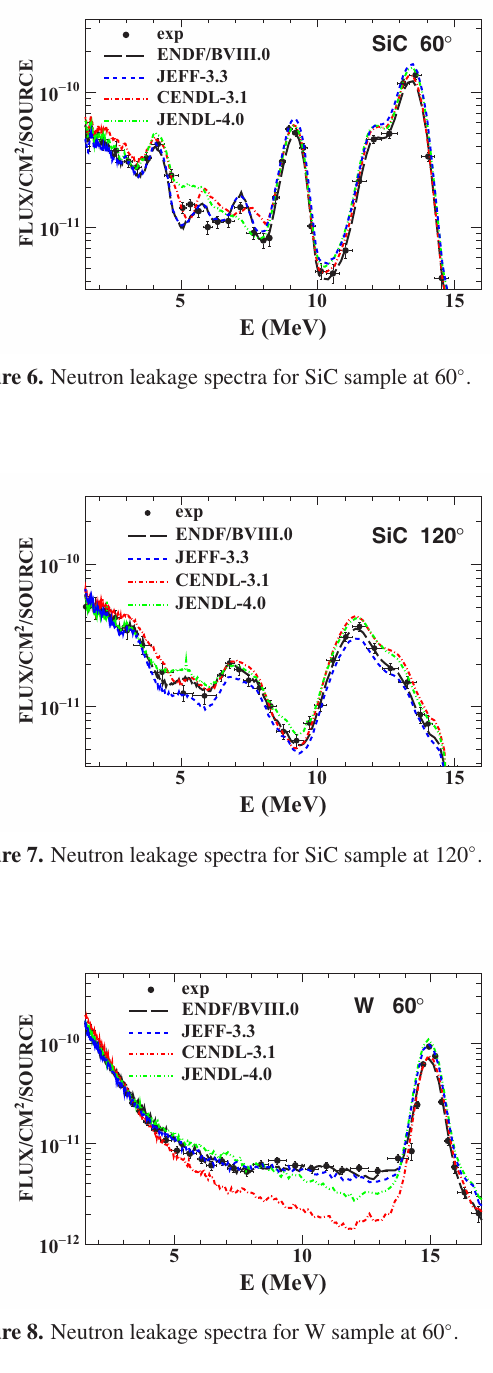
Figure 10. Neutron leakage spectra for U sample at 60 ◦